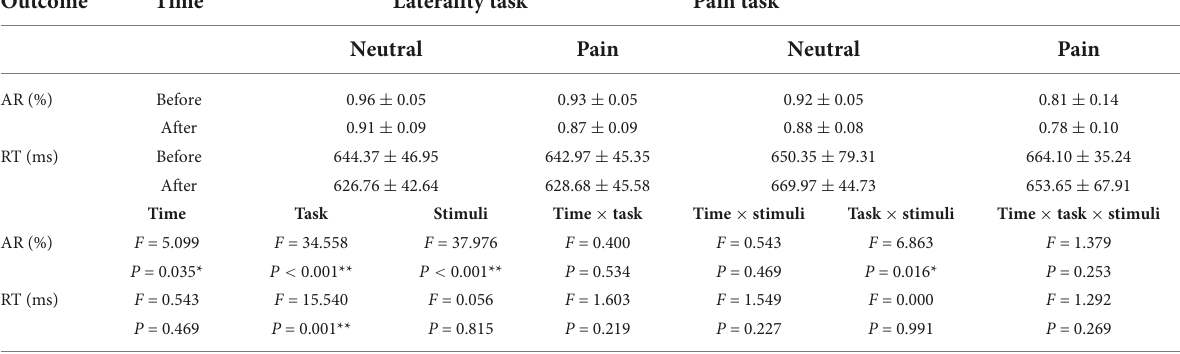
TABLE 4 Statistical analysis of the pain empathy